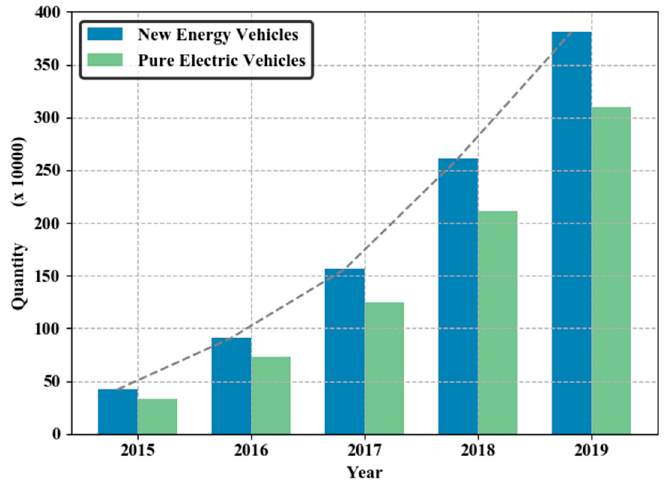
Figure 1. New energy vehicles and pure electric vehicles (EVs) in the last five years. New energy vehicles include EVs, hybrid EVs, and other clean energy vehicles [1].